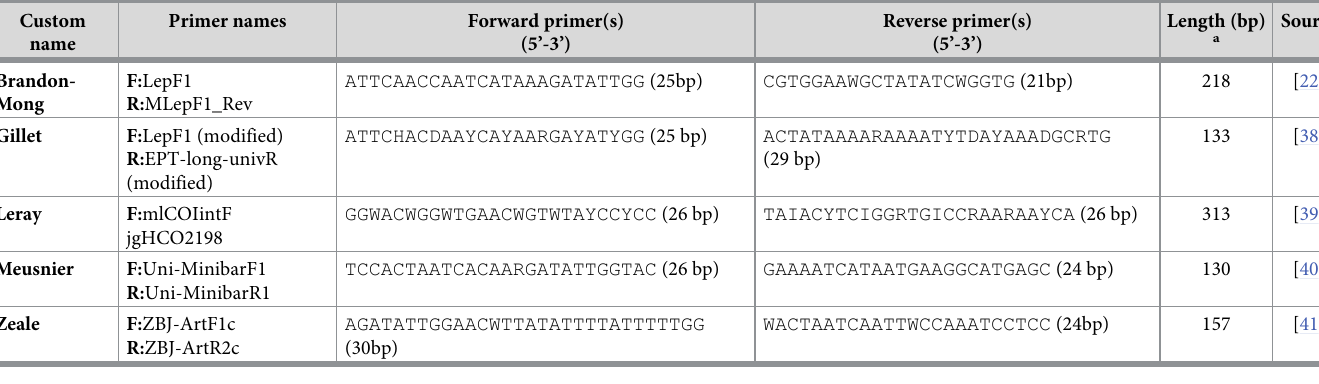
Table 2. Details of the five primer sets used in this